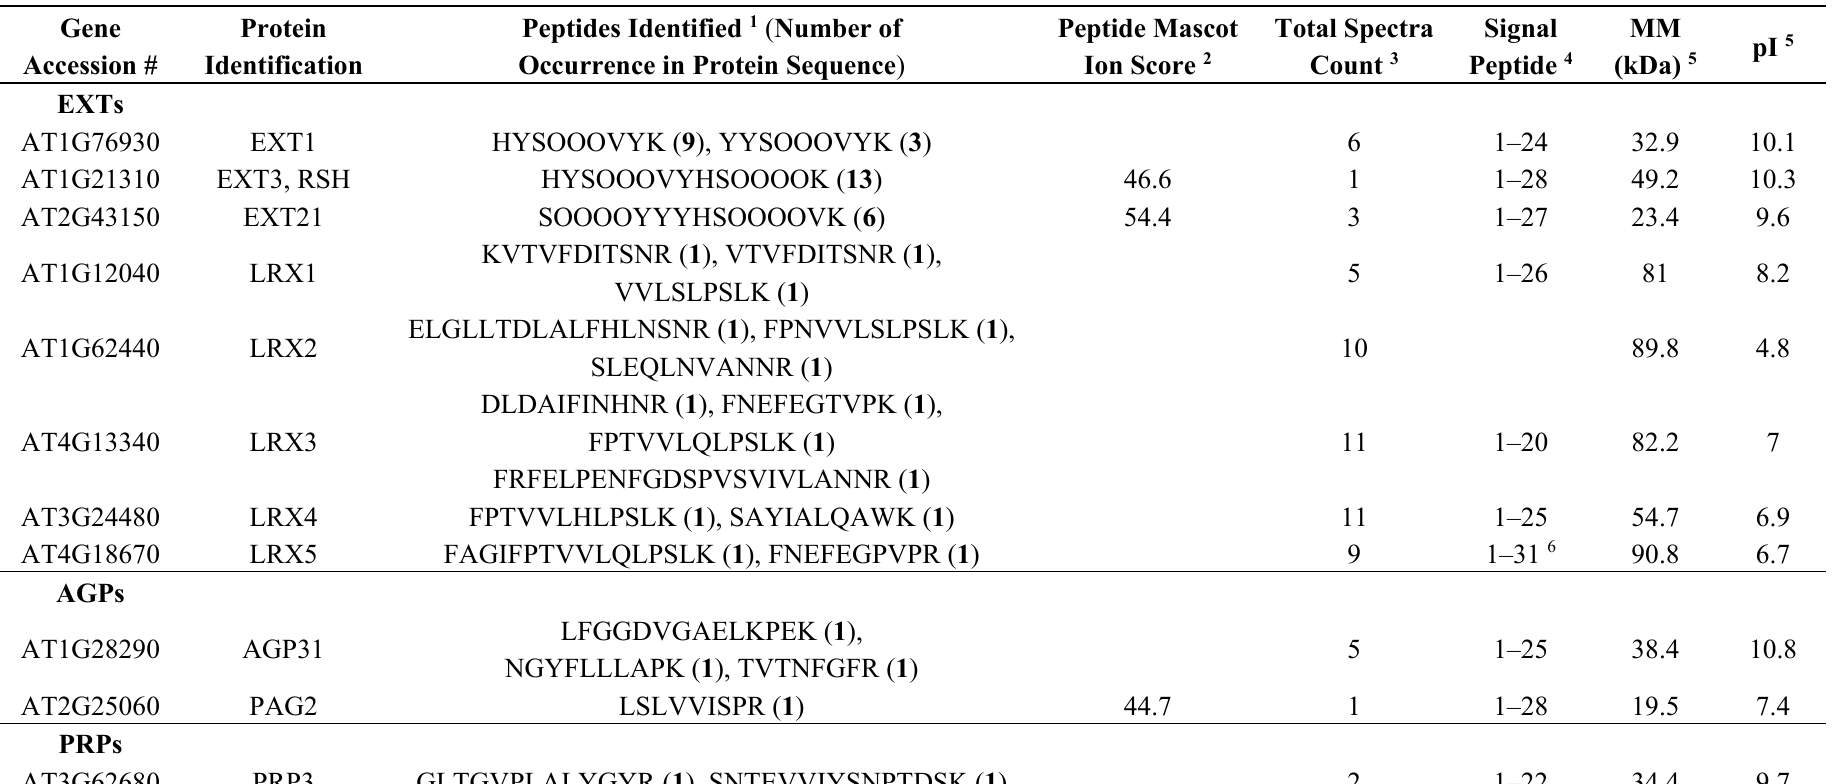
Table 3. HRGPs Identified in MT Cell Wall